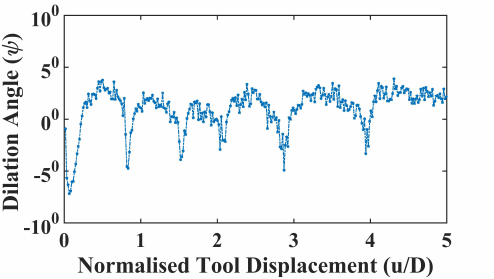
Figure 9. Evolution of dilation angle within the shear band as a function of tool